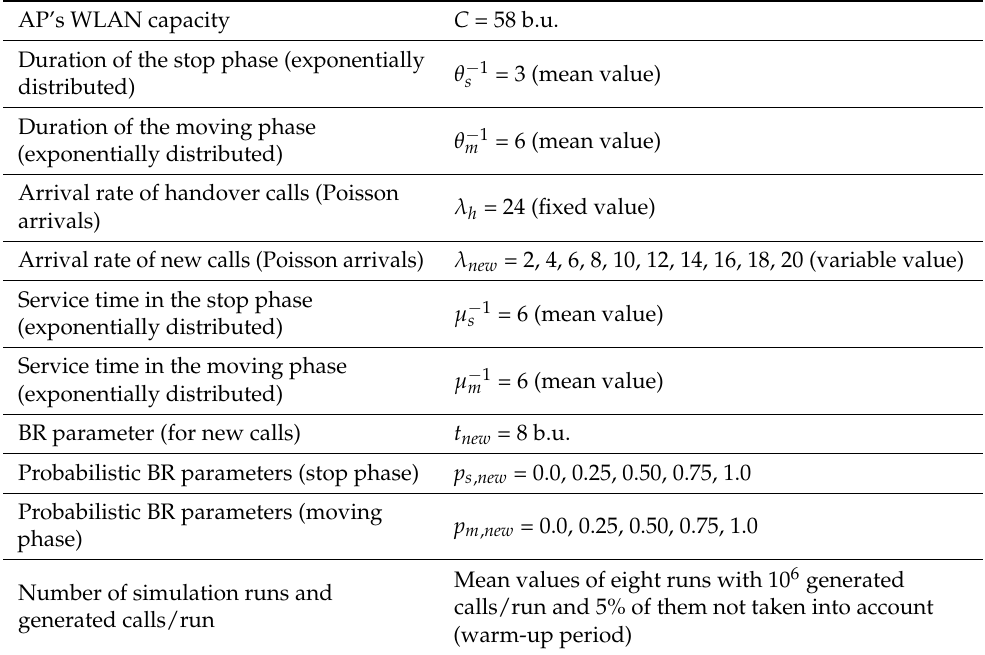
Table 1. List of simulation